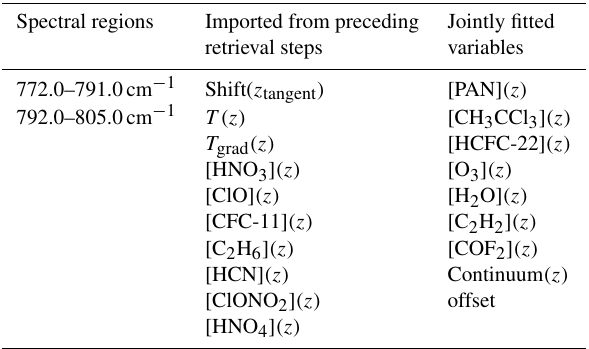
Table 1. Retrieval details on the spectroscopic region, species im- ported from preceding retrieval steps and variables fitted jointly dur- ing the retrieval process. Brackets denote mixing